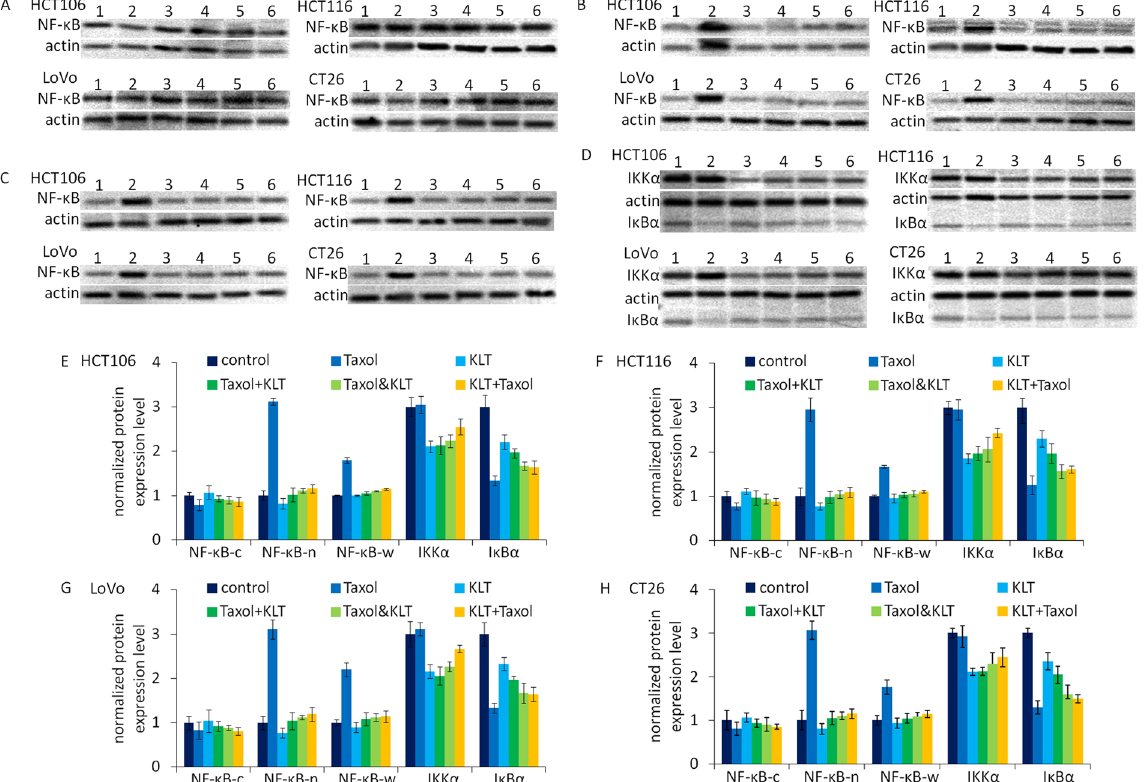
Figure 3. Western blotting analysis of NF- κΒ , IKK α and I κΒα expression in four colorectal cancer cell lines, HCT106, HCT116, LoVo, and CT26, which were treated with different combinations of drugs. β -Actin was used as a loading control. The numbers represent different treatment groups: 1: control; 2: Taxol; 3: KLT; 4: Taxol + KLT; 5: Taxol&KLT; and 6: KLT + Taxol. ( A ) NF- κΒ expression in nuclear; ( B ) NF- κΒ expression in cytoplasm; ( C ) NF- κΒ expression in whole cell lysate; ( D ) IKK α and I κΒα expression in cytoplasm; ( E – H ). The densitometric analysis bar diagram of NF- κΒ , IKK α and I κΒα expression in the four colorectal cancer cell lines. Where NF- κΒ -c represents NF- κΒ expression in cytoplasm, NF- κΒ -n represents NF- κΒ expression in nuclear, and NF- κΒ -w represents NF- κΒ expression in whole cell. ( E ) HCT106; ( F ) HCT116; ( G ) LoVo; ( H )